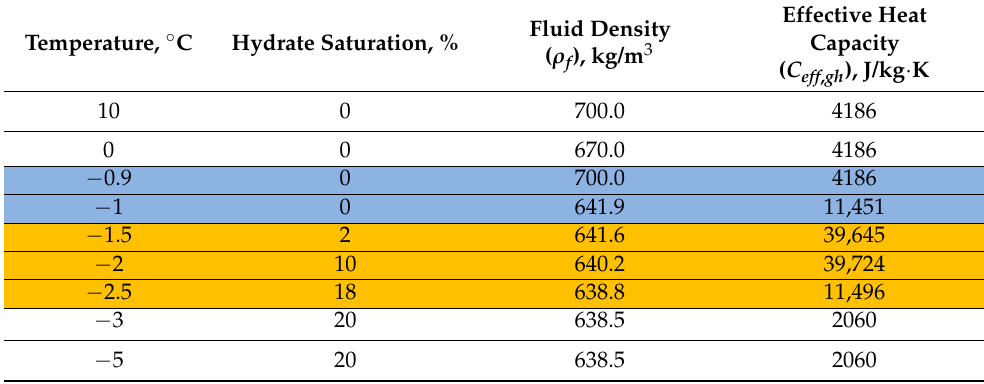
Effective Heat Fluid Density